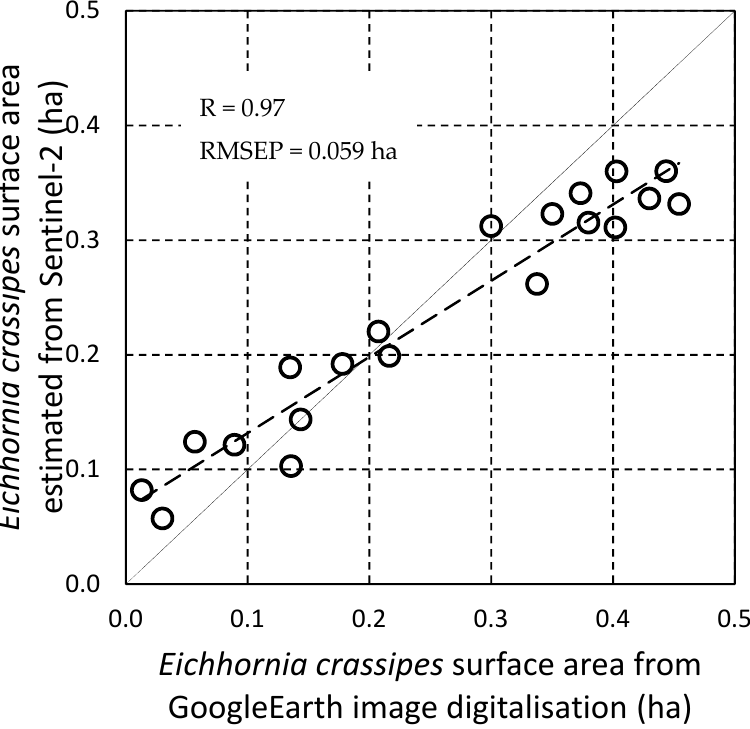
Figure 12. The surface area of Eichhornia crassipes obtained by digitizing on Google Earth with that estimated by Sentinel-2.